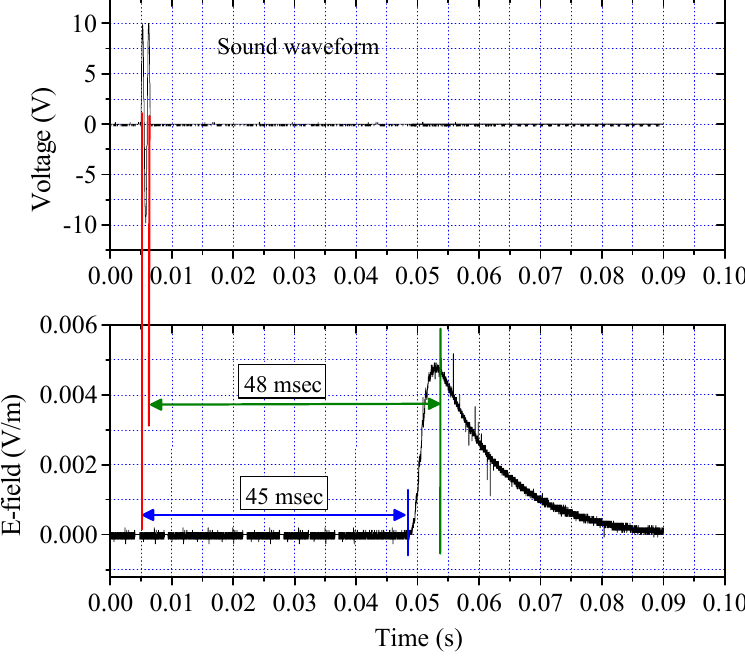
Figure 7 . Integrated E-field detected under a thundercloud.